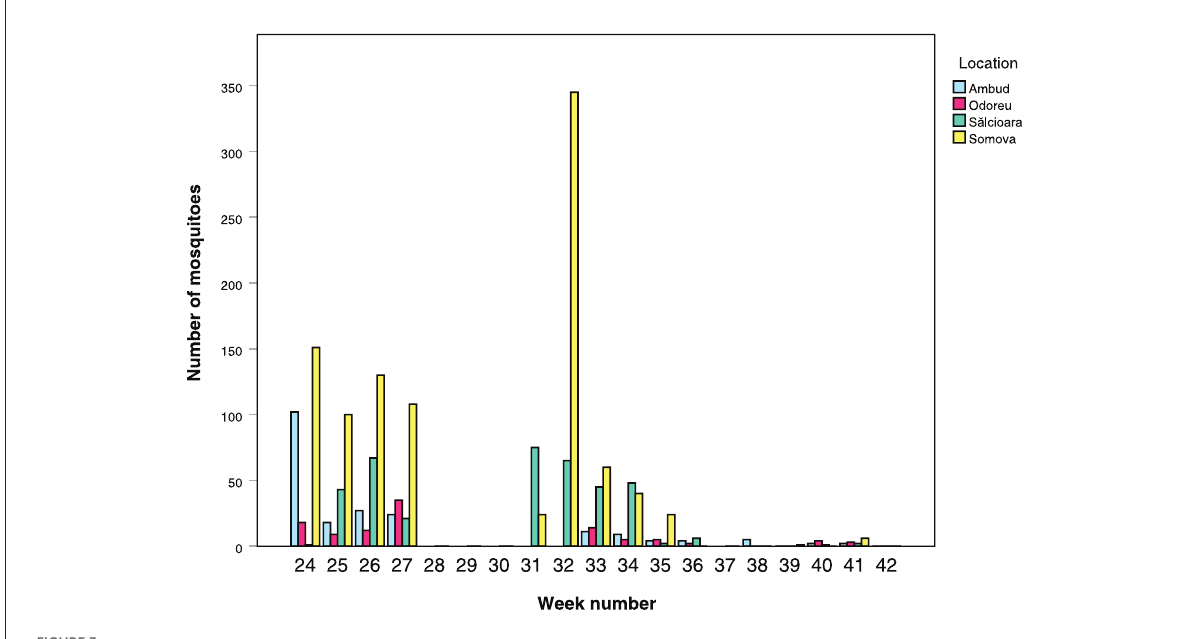
FIGURE3 Number of mosquitoes caught inside the pig cages per week for all four locations. Note that there were no pigs inside the cages, and thus no collections, in week 28, 29, 30 ( + 31, 32 for Satu Mare’s Ambud and Odoreu locations) and week